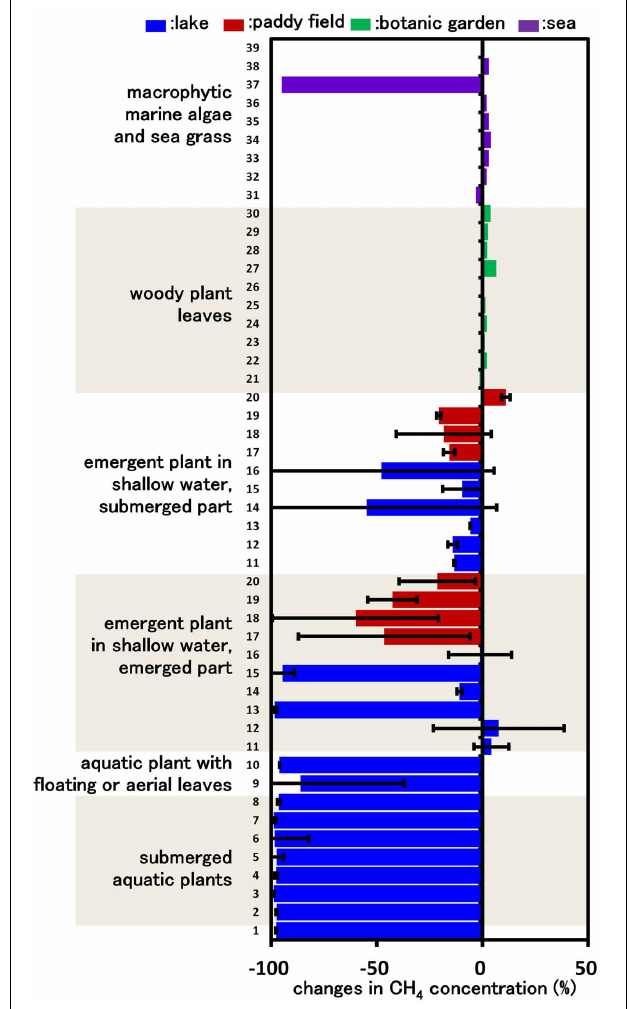
FIGURE 1 | CH 4 consumption in cultures inoculated with various plant parts. Columns indicate the changes in CH 4 concentration after incubation for 14 days in vials containing mineral medium amended with 5% CH 4 and plant parts. Each column indicates a single determination inoculated with each plant species (listed in Supplemental Table 1). Data for emergent and submerged aquatic plants represent the mean ± SD from three different glass bottles independently prepared in parallel, while data for tree leaves and sea weed are single